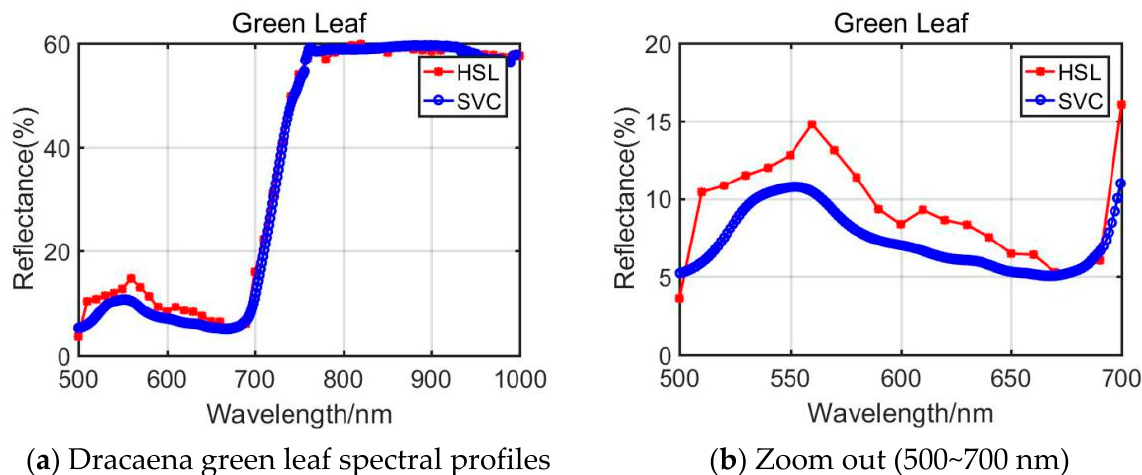
Figure 4. Dracaena green leaf spectral profiles.